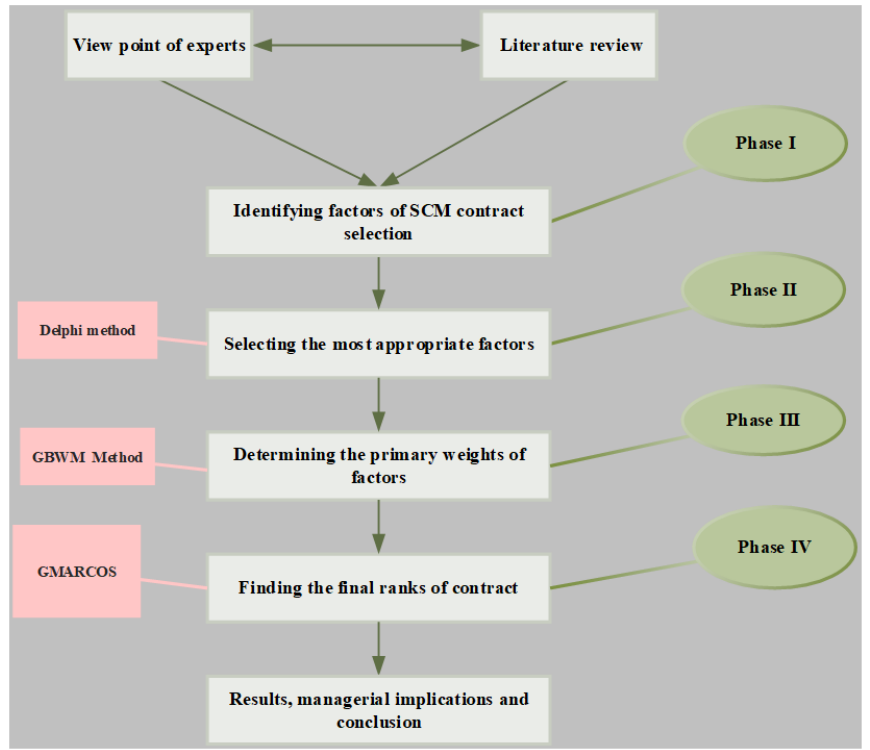
Figure 1. Research methodology.